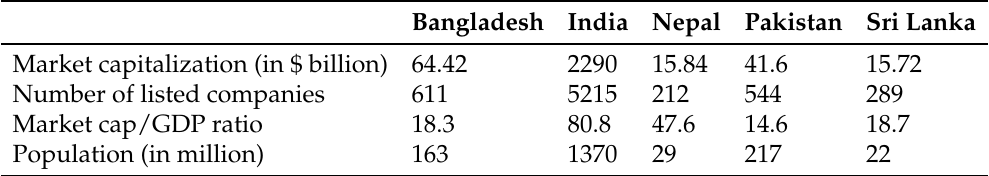
Table 1. Fundamental